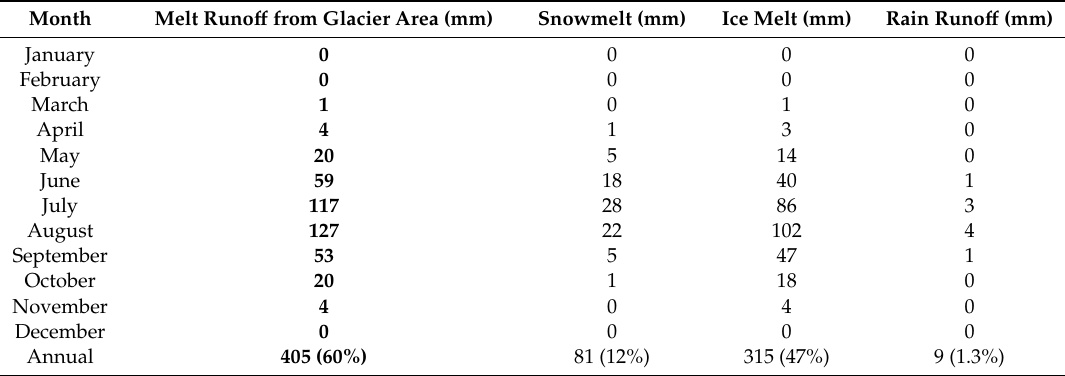
Figure 7. Monthly average contribution of ice melt to total discharge during the modeling period. Table 6. Average monthly melt contribution from glacier area to total discharge from the Hunza